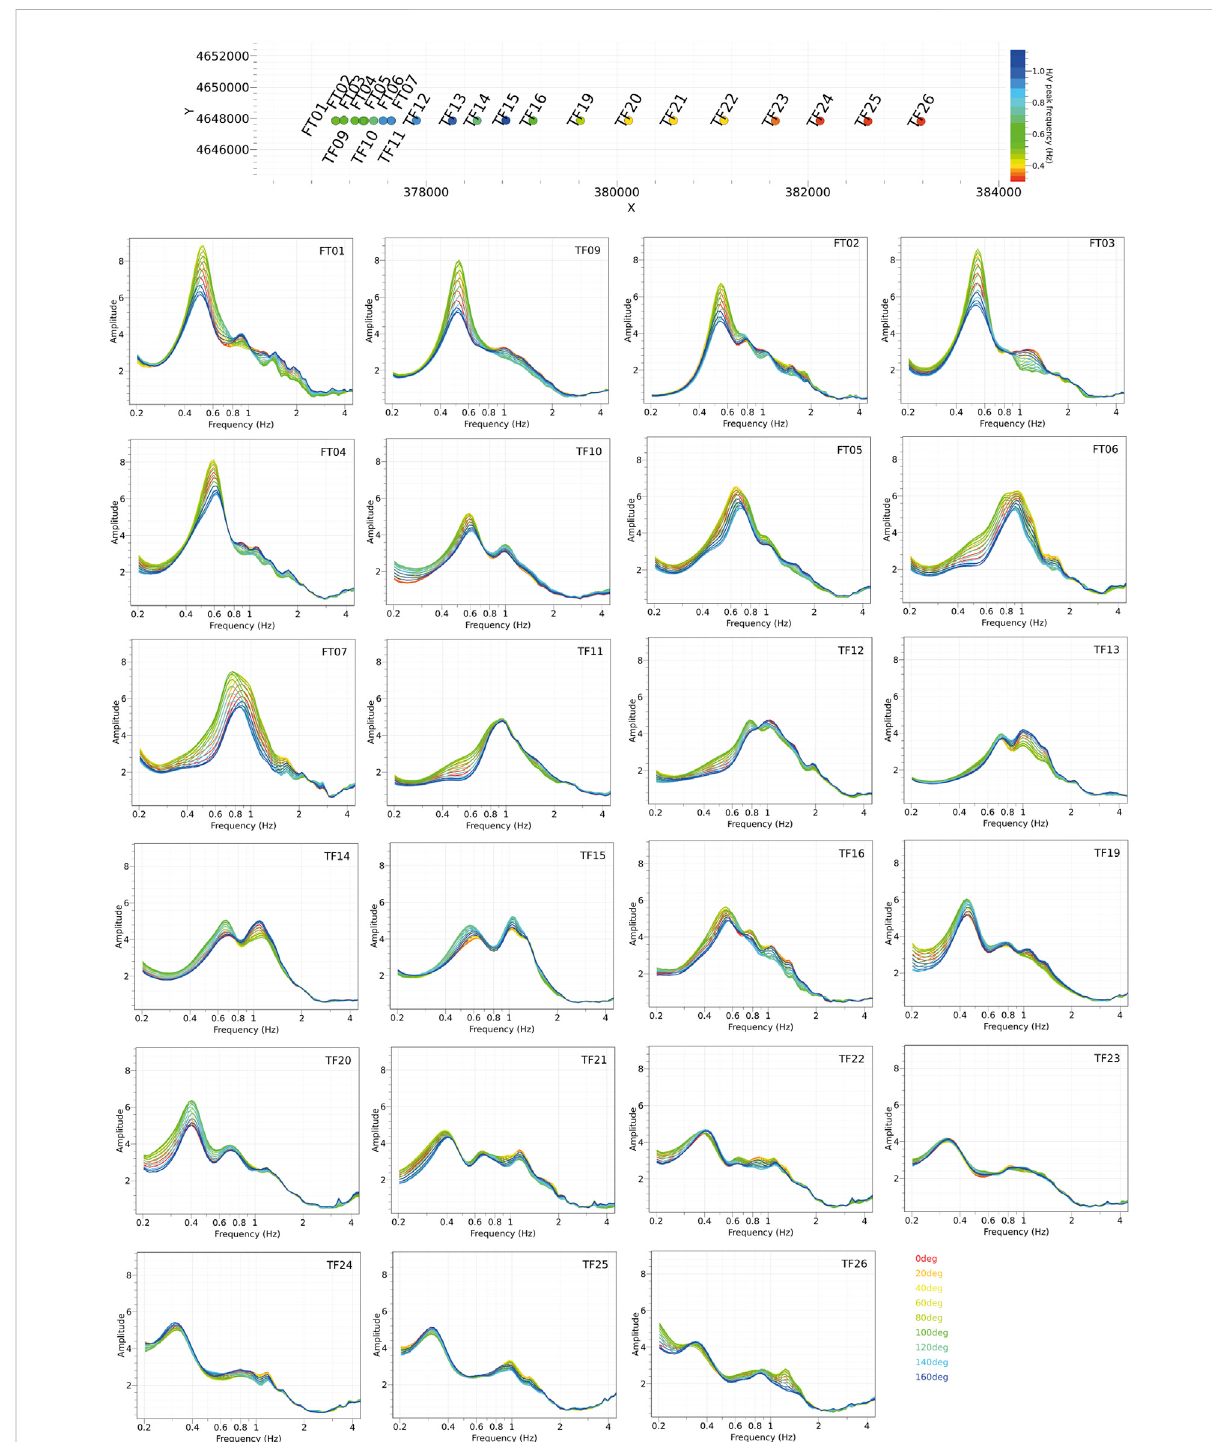
FIGURE 12 Directional HVNSR of Section